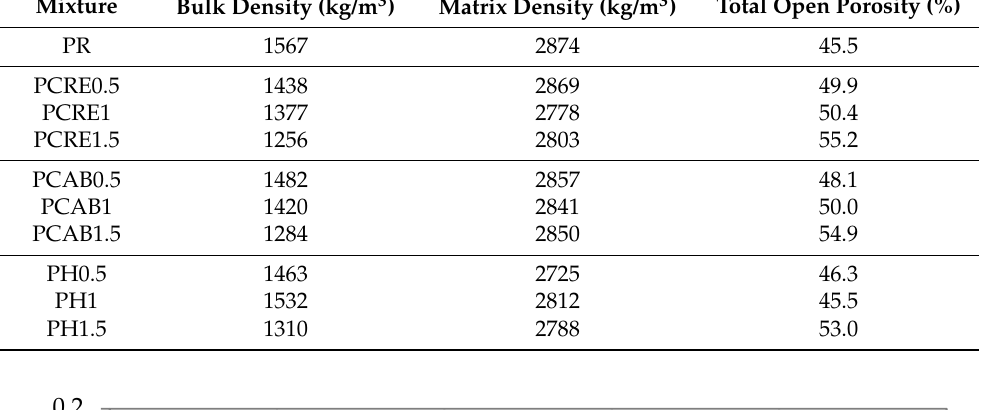
Table 3. Basic material properties of studied plaster mixtures. Mixture